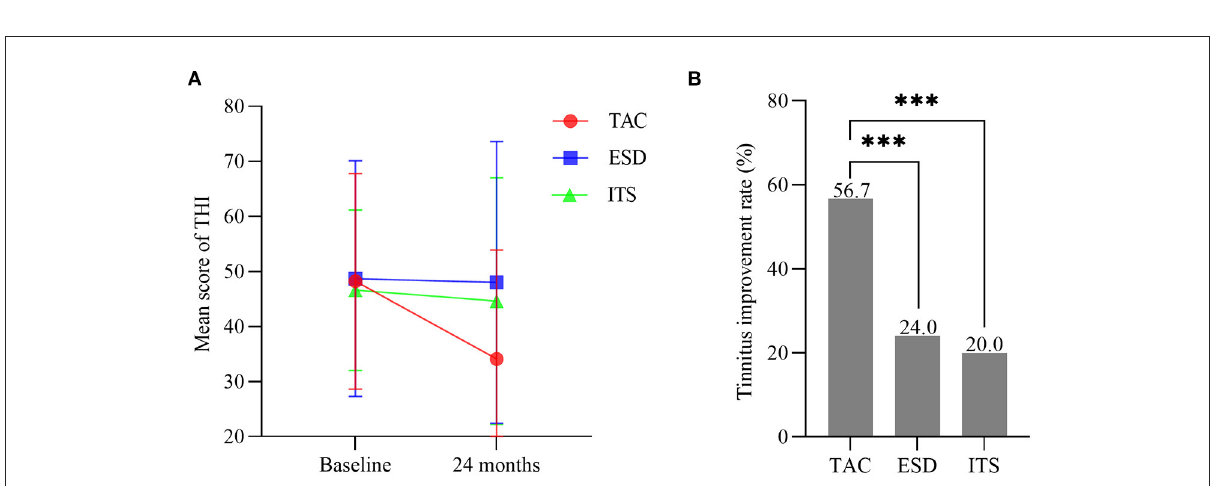
24 months for the TAC group than for the ESD and ITS groups ( t = 7.154, p < 0.001; t = 4.181, p < 0.001). The aural fullness improvement rate in patients with TAC was 56.7% (34/60). In